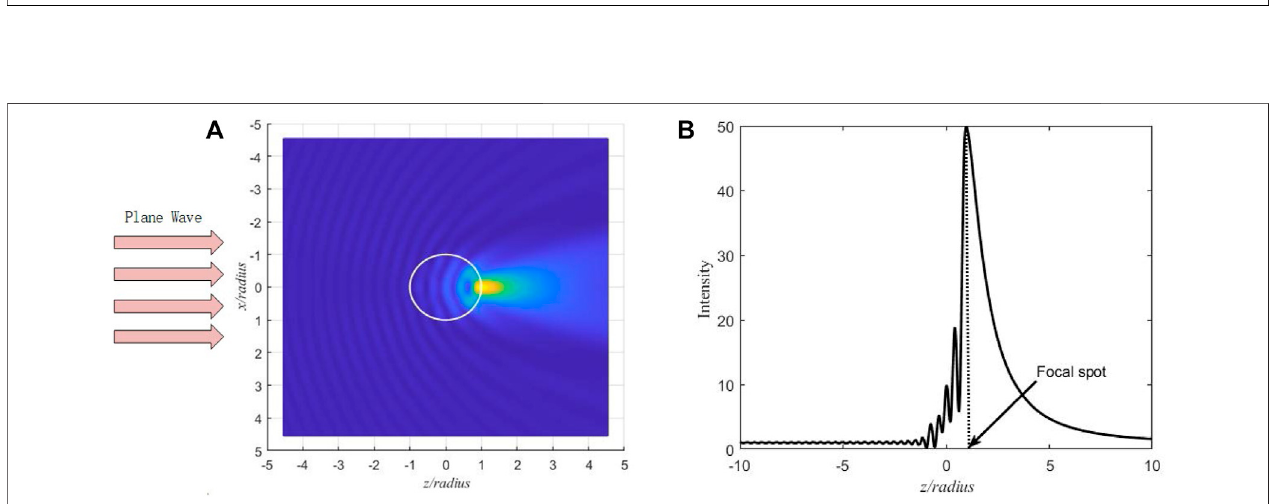
FIGURE 6 | Images of internal and near-external fi elds for a plasma sphere with R = 20 cm, f i = 2.1 GHz, f p = 2 GHz, and ] c = 60 GHz. (A) The three-dimensional fi eld distribution in the plane x – z and (B) the intensity distribution along the z- axis.